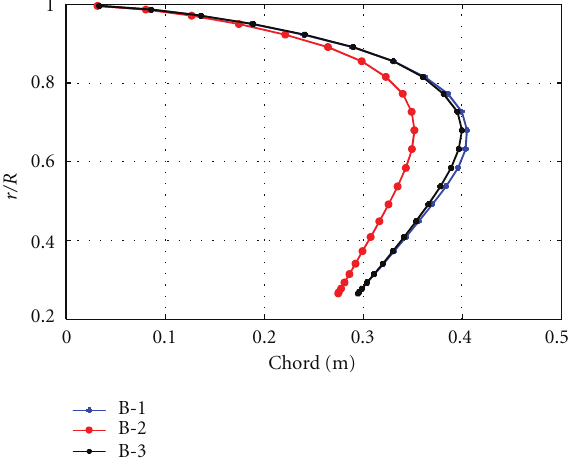
Figure 17: Chord lengths, fore propeller.